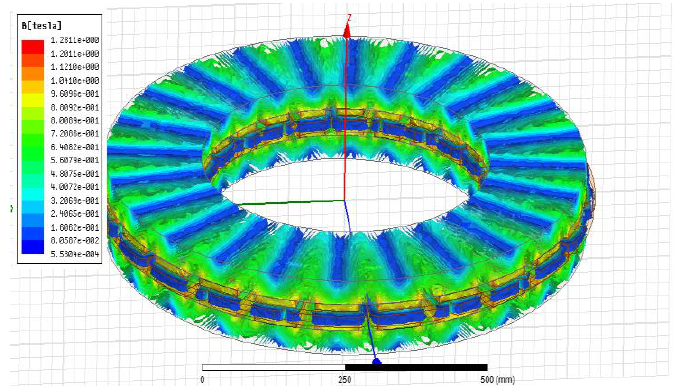
Figure 5. Magnetic flux density distribution in AFPMSG.